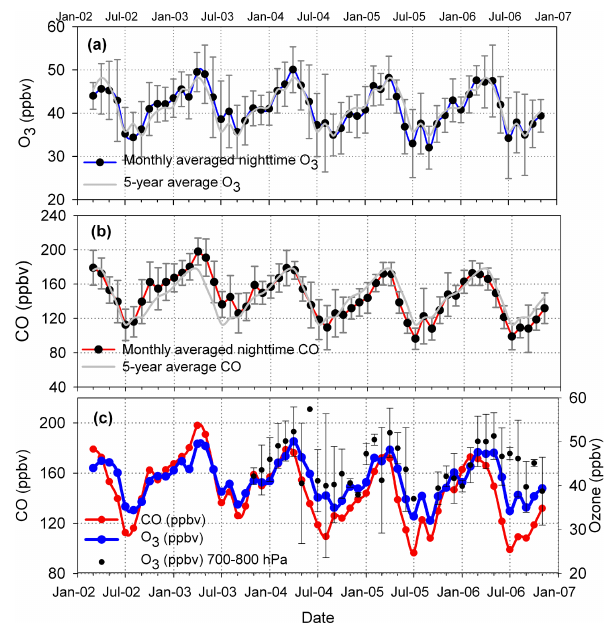
Fig. 3. Monthly averages of (a) O 3 and (b) CO nighttime data (20:00–08:00PST) for March 2002 to December 2006 at Whistler Peak. Error bars are one standard deviation about the mean of all hourly data. The gray lines show the 5-yr averages. (c) Monthly av- erages of both O 3 and CO from Whistler peak and O 3 mixing ratios from ozonesondes flown at Kelowna, British Columbia. The error bars are one standard deviation of the reported values of O 3 from 700–800hPa.